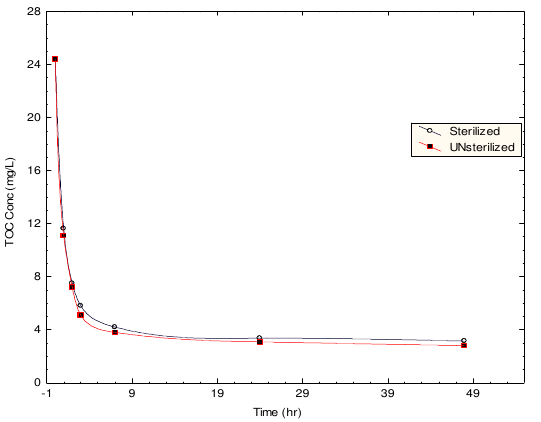
Fig. 8. Effect of sterilization on the concentration level of COD pollutant with time at T=25 o C, pH 7, wastewater/(Algae broth) ratio =1.